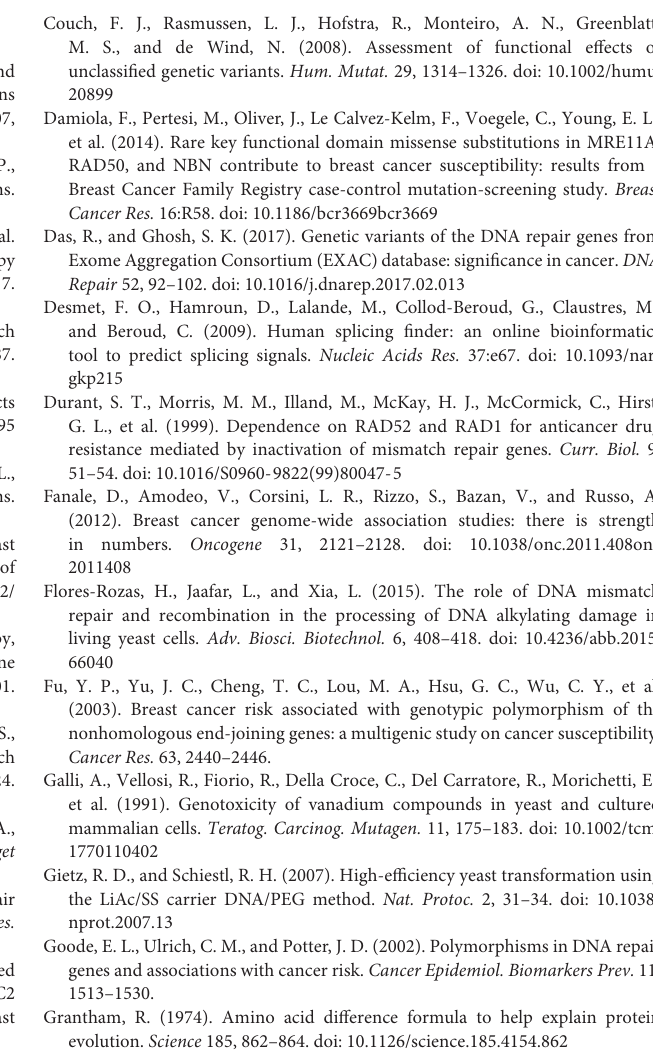
FIGURE S1 | Expression of human BRCA1 wt and missense variants in the RSY6 wt and in DNA repair mutant strains of S. cerevisiae . BRCA1 was detected in the total protein extracts from yeast strains grown in galactose by Western blot analysis with anti-BRCA1 antibody. Extracts from yeast expressing BRCA1 wild-type and missense variants were loaded as indicated on the top of the figure. In blue extract were prepared from yeasts expressing neutral variants, in red form yeast expressing pathogenic variants, in green from the VUS-expressing yeast, and in black from BRCA1wt or negative control (vector pYES2). The level of BRCA1 was determined in all the strains used: RSY6, mre11 (cid:49) , rad50 (cid:49) , rad51 (cid:49) , and msh6 (cid:49) . Western blot analysis in msh2 (cid:49) strain was already reported (Maresca et al., 2015). Loading control was evaluated by detecting the level of PGK. TABLE S1 | Histopathological and clinical features of patients. Histotype, grade and receptors status of the tumors are